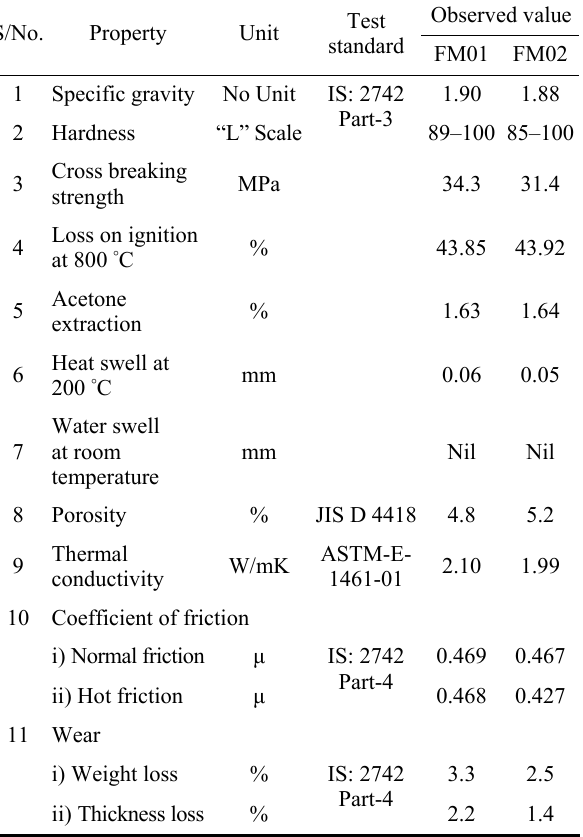
Table 3 Test results of various characteristics of the developed composites.